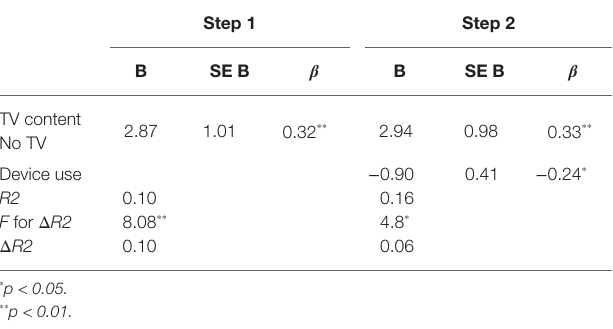
TABLE 8 | Summary of stepwise regression analysis for variables predicting SEDCI-2 – Grammar ( n = 76).